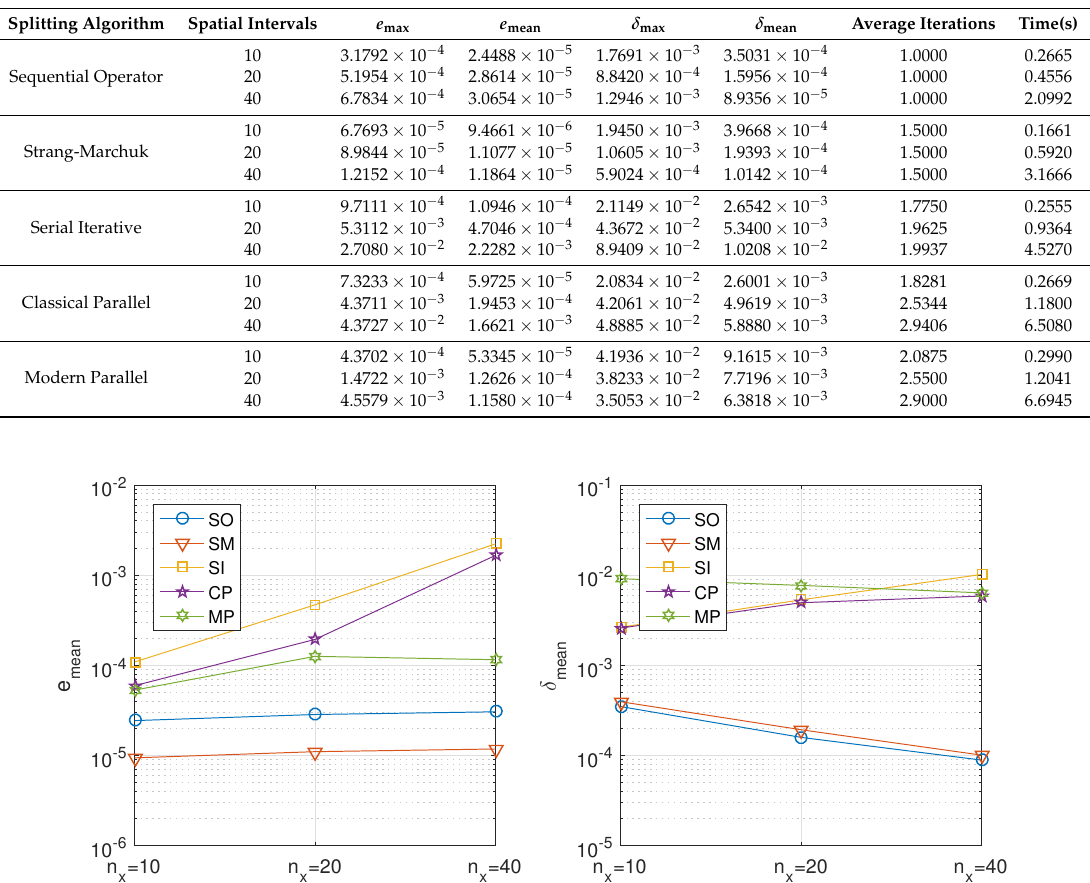
Table 18. Fractional diffusion equation. Results for the directional decomposition with 320 time steps and different number of spatial subintervals.